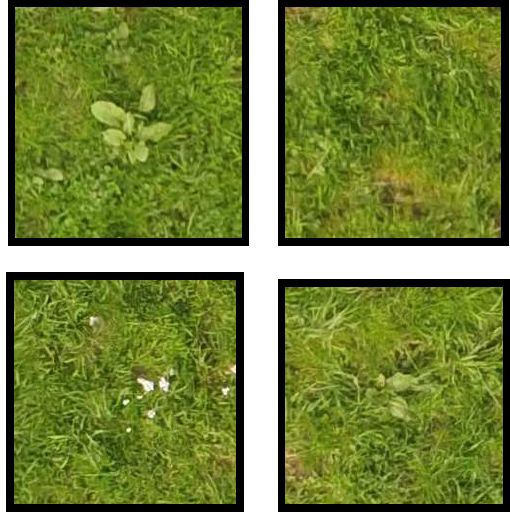
Figure 7. Standalone 227x227 pixels input pictures obtained from the orthomosaic generated from the UAV flight: a) Rumex centred (top-left), b) Grassland (top-right), c) Grassland and other plant species (bottom-left), and d) Rumex centred in an earlier stage (bottom-right). To train the model, a randomized selection of 75% of both groups has been used as training data. Using a randomized cross-validation, 30 validation rounds were performed. Based on the average of these 30 runs, a confusion matrix was created (Figure 8).